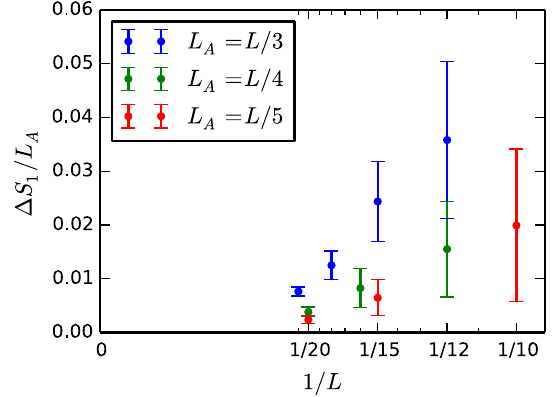
FIG. 6. Scaling of the von Neumann entropy deviation Δ S 1 =L , averaged over all eigenstates with 1 =L , for constant ratio L A in the range 0 . 28 < β < 0 . 32 . As in Fig. 5, the error bars represent one standard deviation away from the mean. Even though this plot considers the case where the subsystem size L A becomes infinite as L → ∞ , the entropy deviations are going to zero rapidly as L becomes larger.